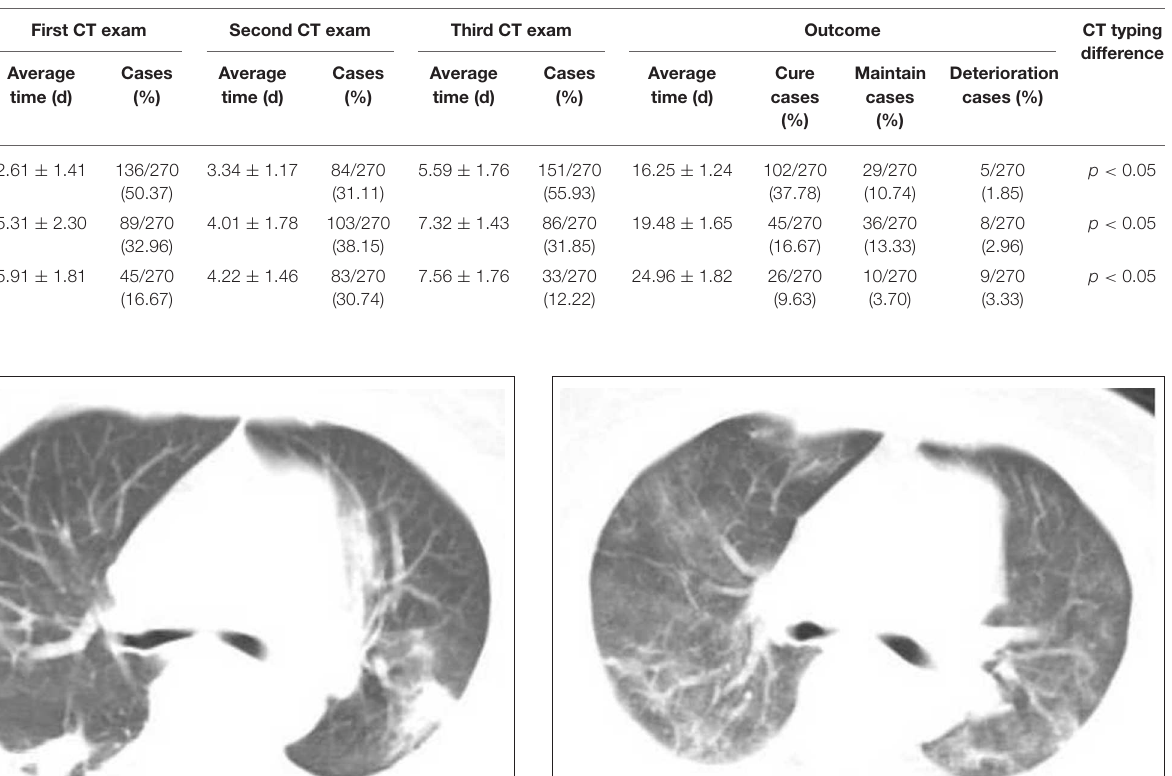
TABLE 2 | Evolution of lung lesions CT typing.